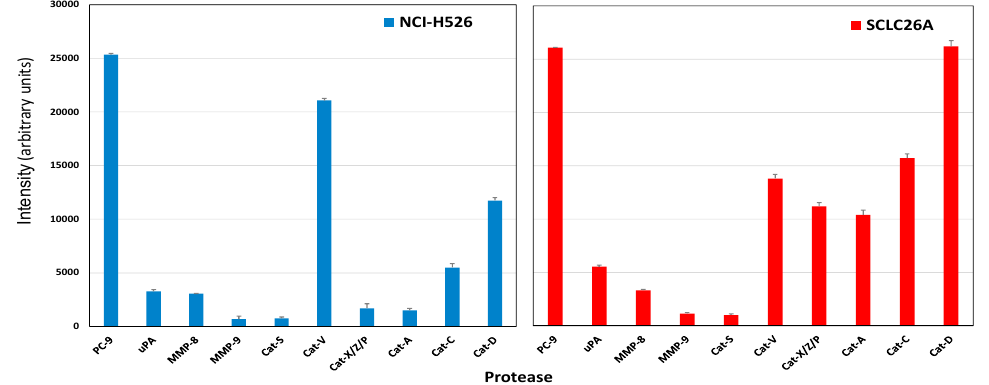
Figure 2. The figure shows selected proteases expressed by NCI-H526 (left side) and SCLC26A (right side) SCLC cell lines, established from a bone metastasis and from pleural effusion, respectively. Values represent mean ± SD.